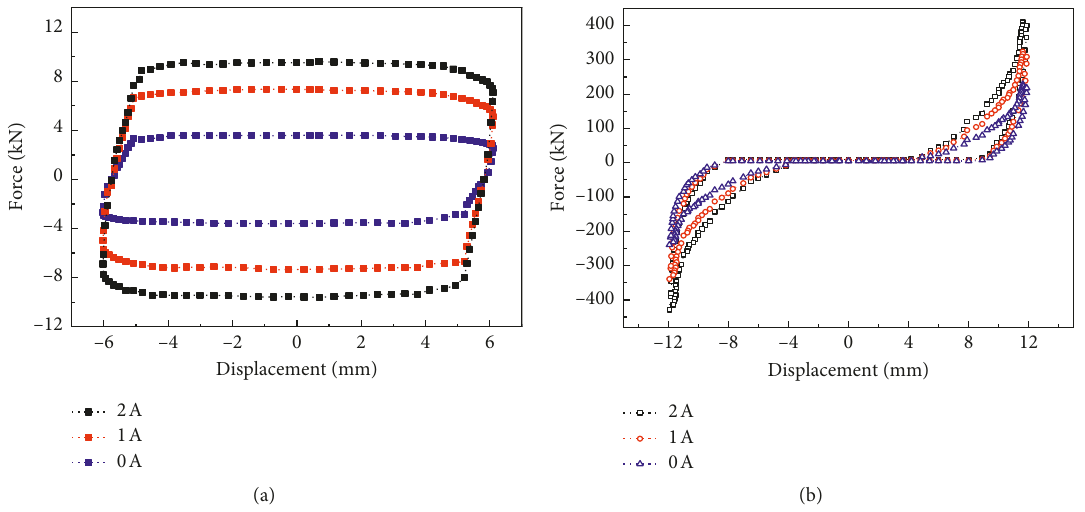
Figure 13: Load-displacement curve of the smart isolator. (a) Small displacement. (b) Large